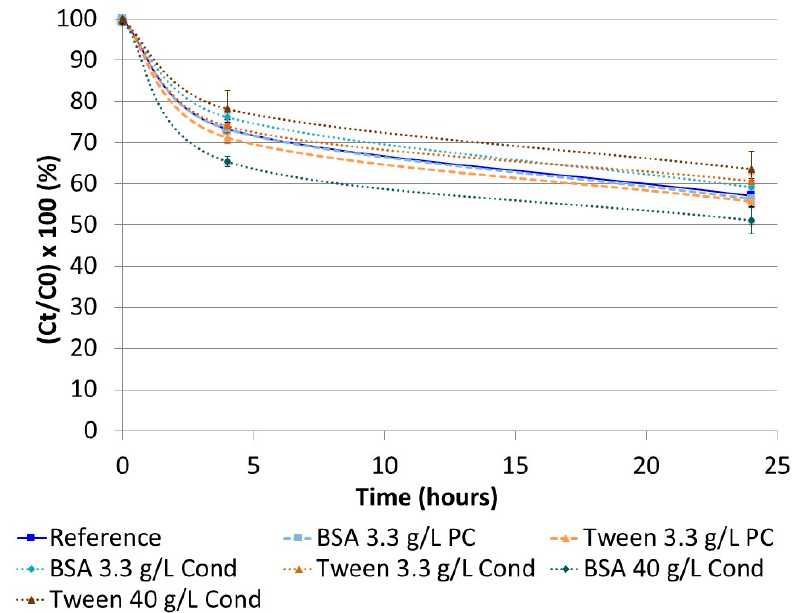
Figure 3. Evolution of insulin concentration during preconditioning and conditioning assays. Ref-